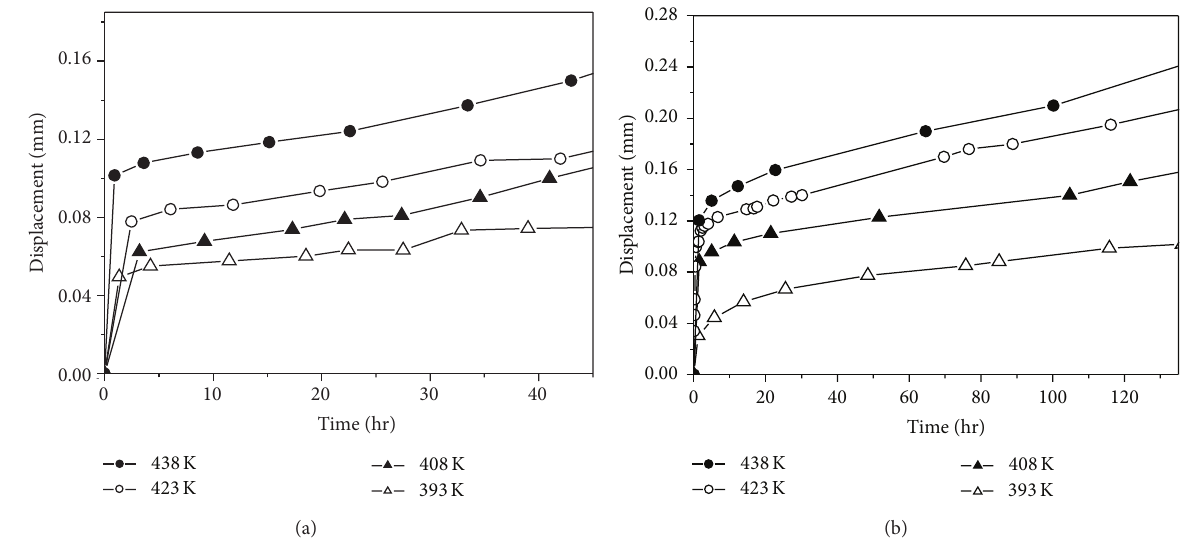
Figure 10: Correlation of displacement-time in the shear creep experiment under different loads: (a) 7.35 N load disc and (b) 29.4 N load disc.